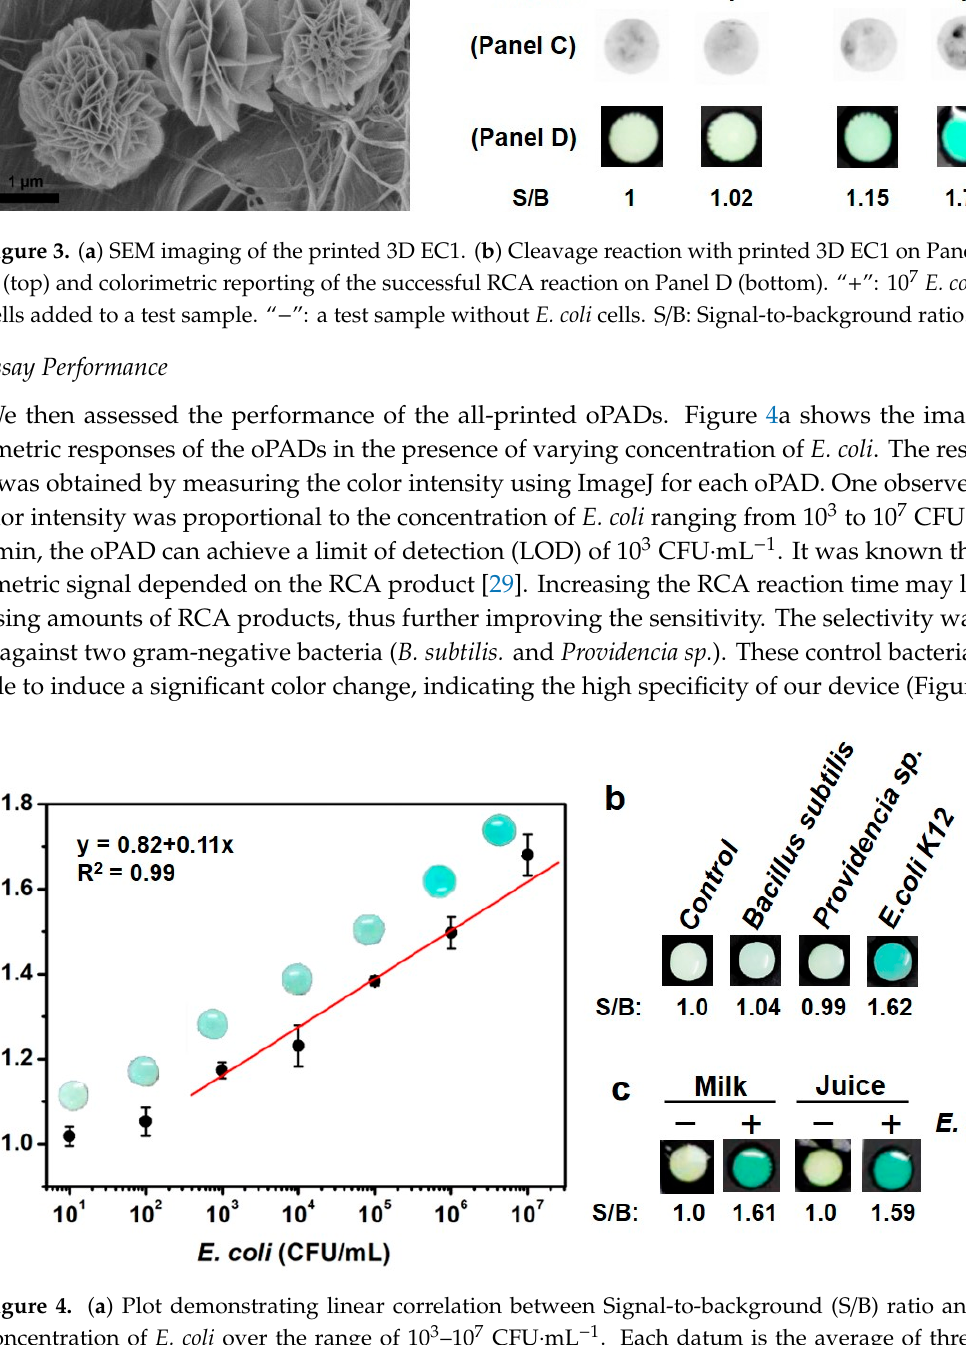
Figure 3. ( a ) SEM imaging of the printed 3D EC1. ( b ) Cleavage reaction with printed 3D EC1 on Panel C (top) and colorimetric reporting of the successful RCA reaction on Panel D (bottom). “+”: 10 7 E. coli cells added to a test sample. “ − ”: a test sample without E. coli cells. S/B: Signal-to-background ratio.